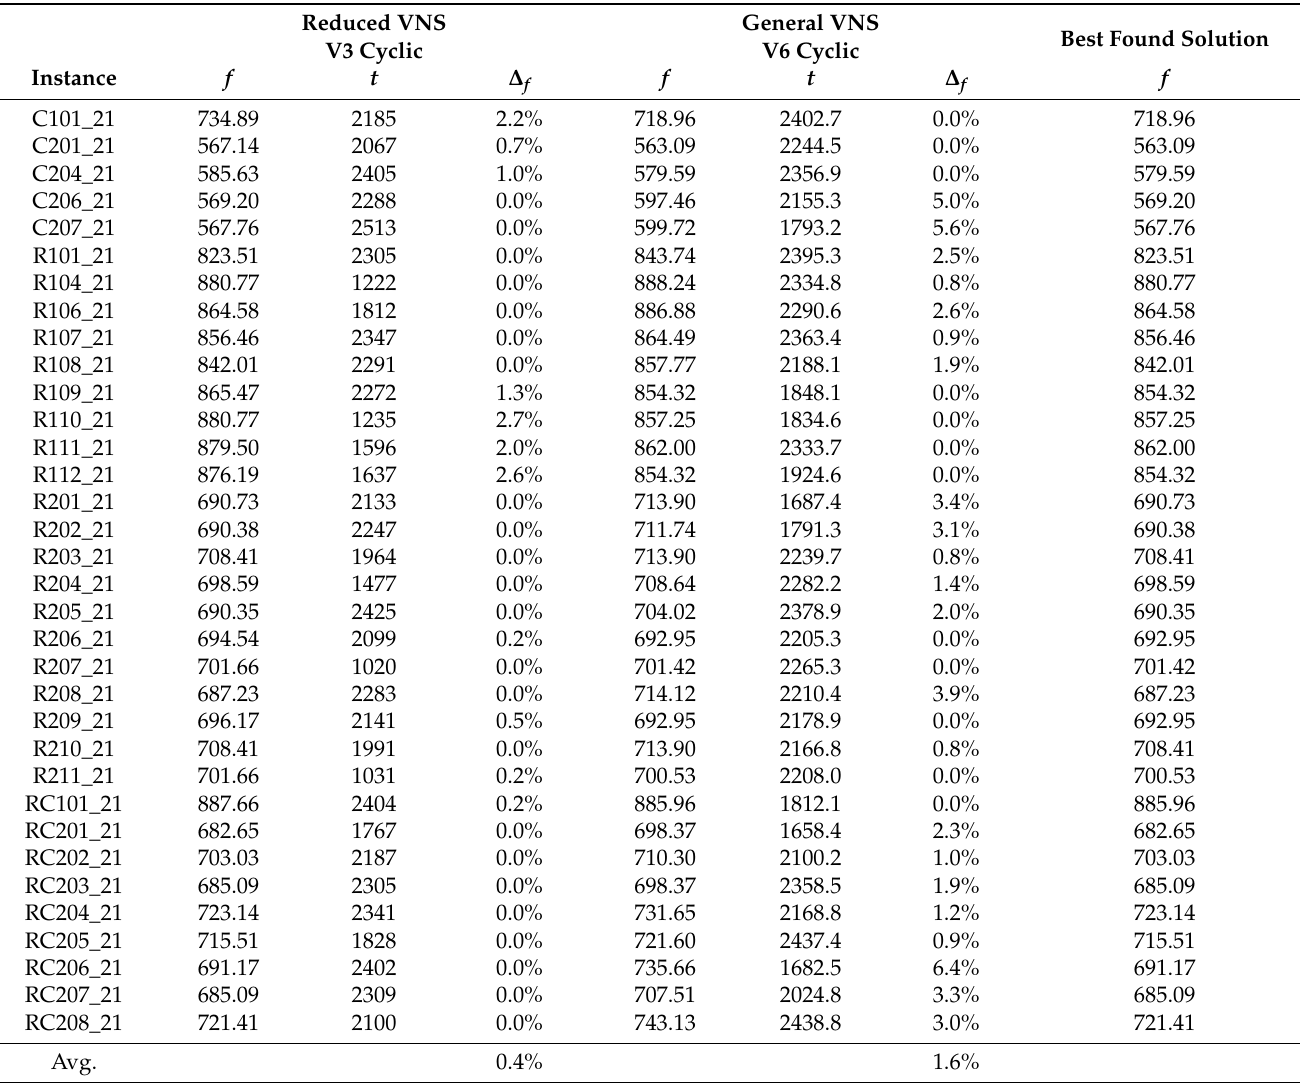
Best Found Solution